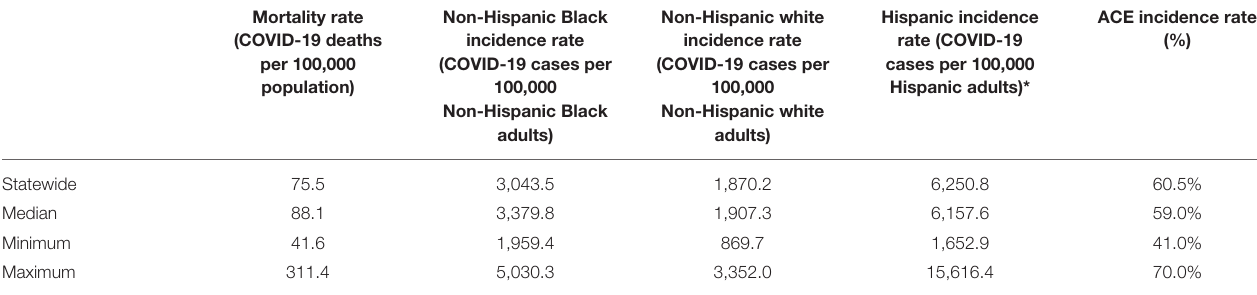
TABLE 1 | Statewide and county-level summary statistics ( n = 46).